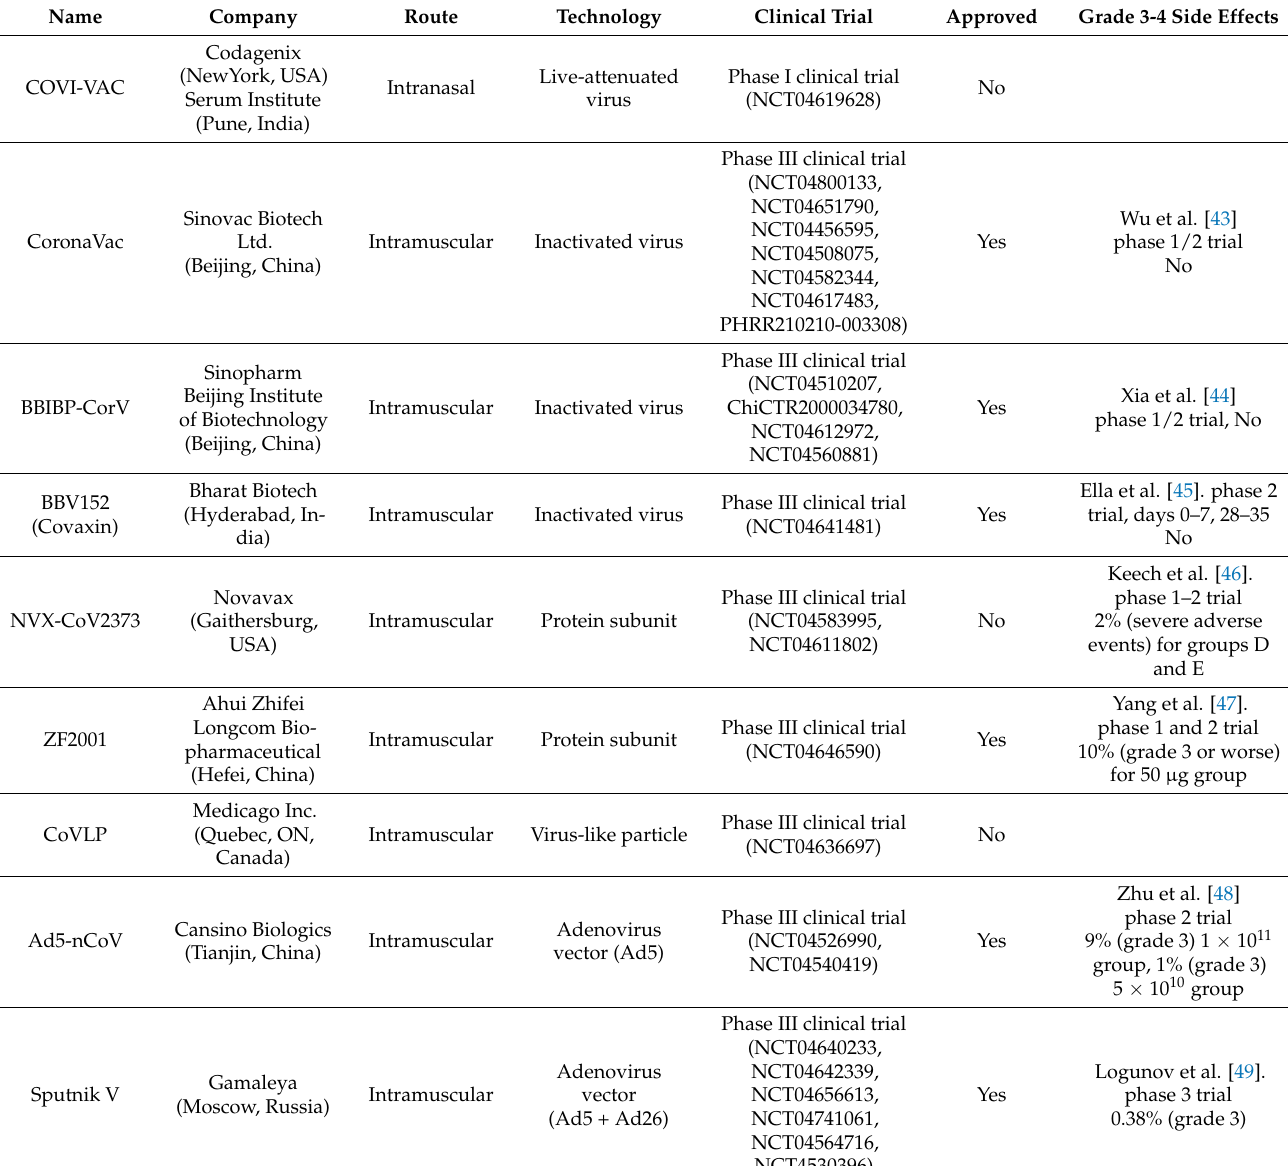
Table 1. Current advances in COVID-19